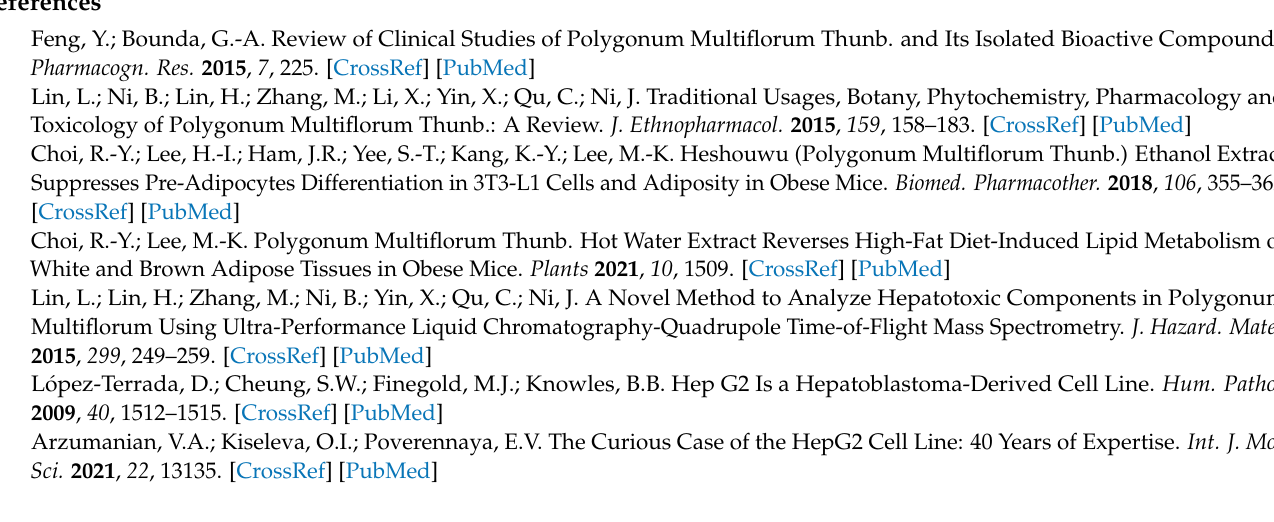
pharmaceutical companies; Table S3: Contents of 6 compounds in different processed PMRP; Table S4: Sample collection information of PMR; Table S5: Sample collection information of